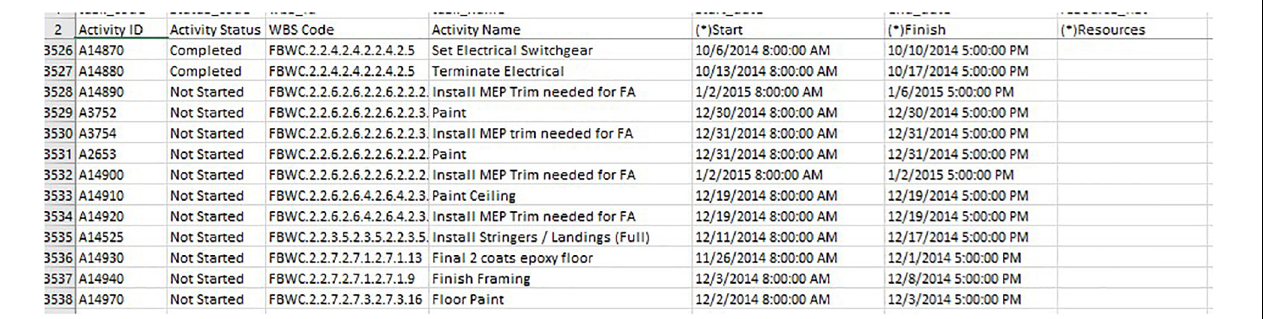
FIGURE 5 | Sample of a “Tasks” spreadsheet exported from